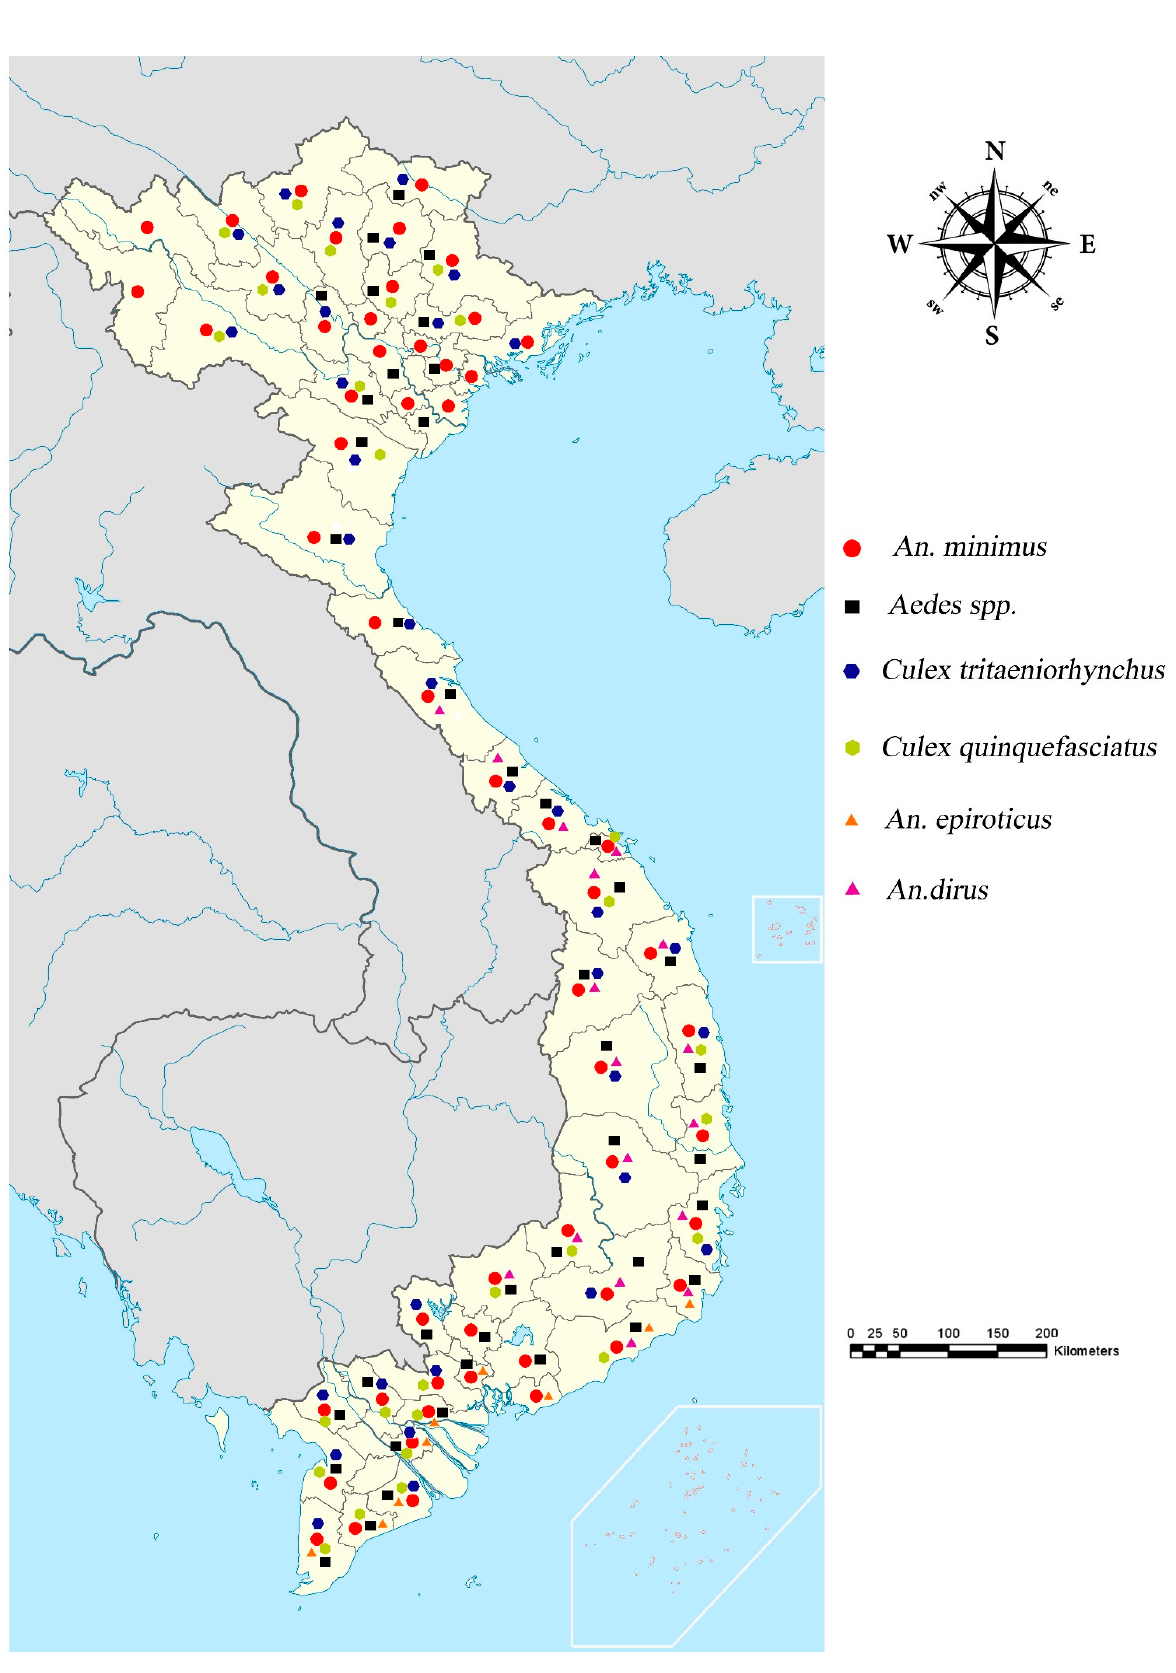
Figure 1. Distribution map of the major vectors.